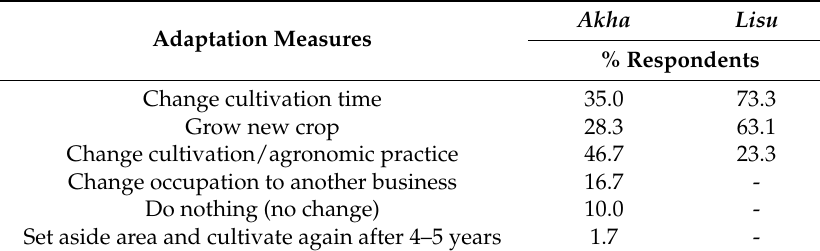
Table 5. Adaptation measures practiced by the respondents.